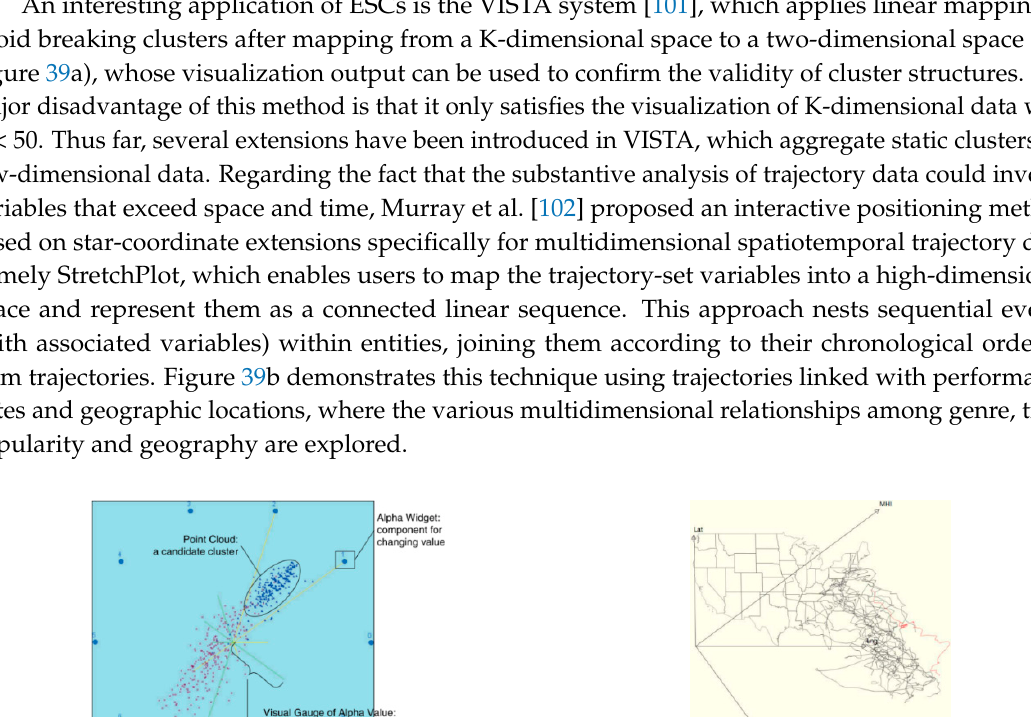
Figure 38. ( a ) Original star coordinate system with a sample of point P (top) and enhanced star coordinate system (bottom) [99]; and ( b ) comparisons of visualization results between original star coordinates and enhanced star coordinates in an example dataset [100].